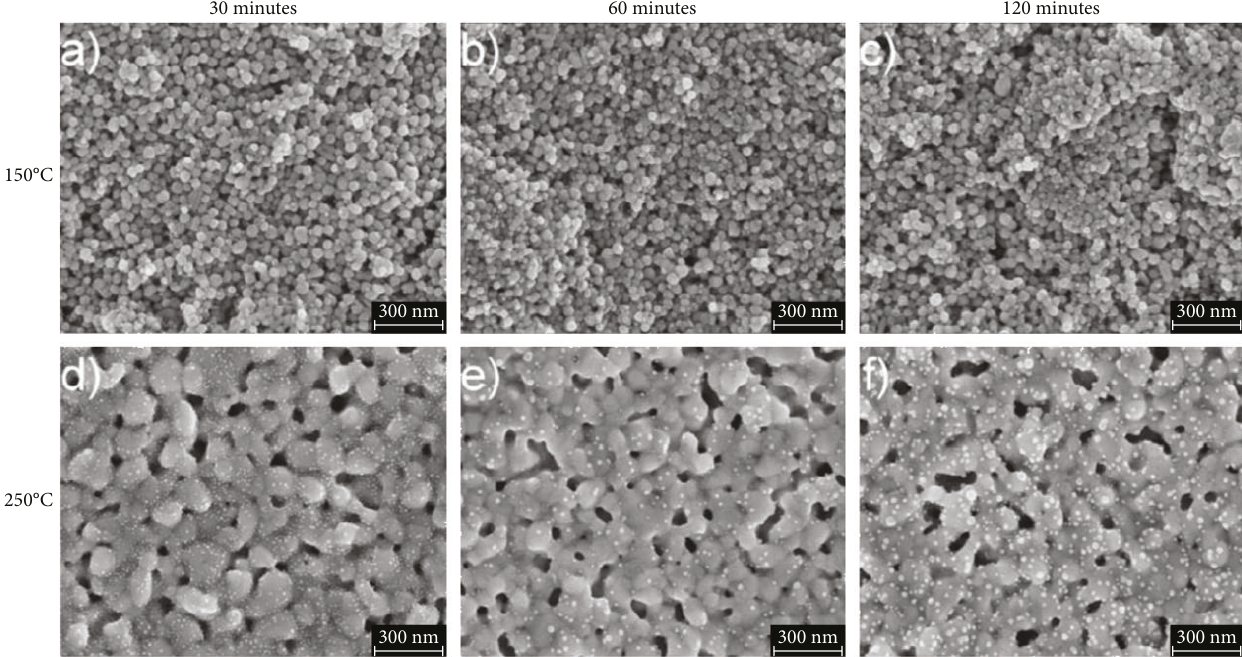
Figure 6: SEM images of AJP printed Ag lines taken at di ff erent temperature and time sintering conditions. Reproduced with permission